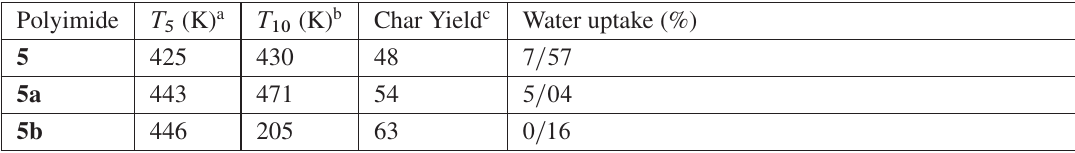
Figure 6. Scanning electron micrographs of PAI-nanocomposite films 5a (a) and 5b (b) . Polyimide